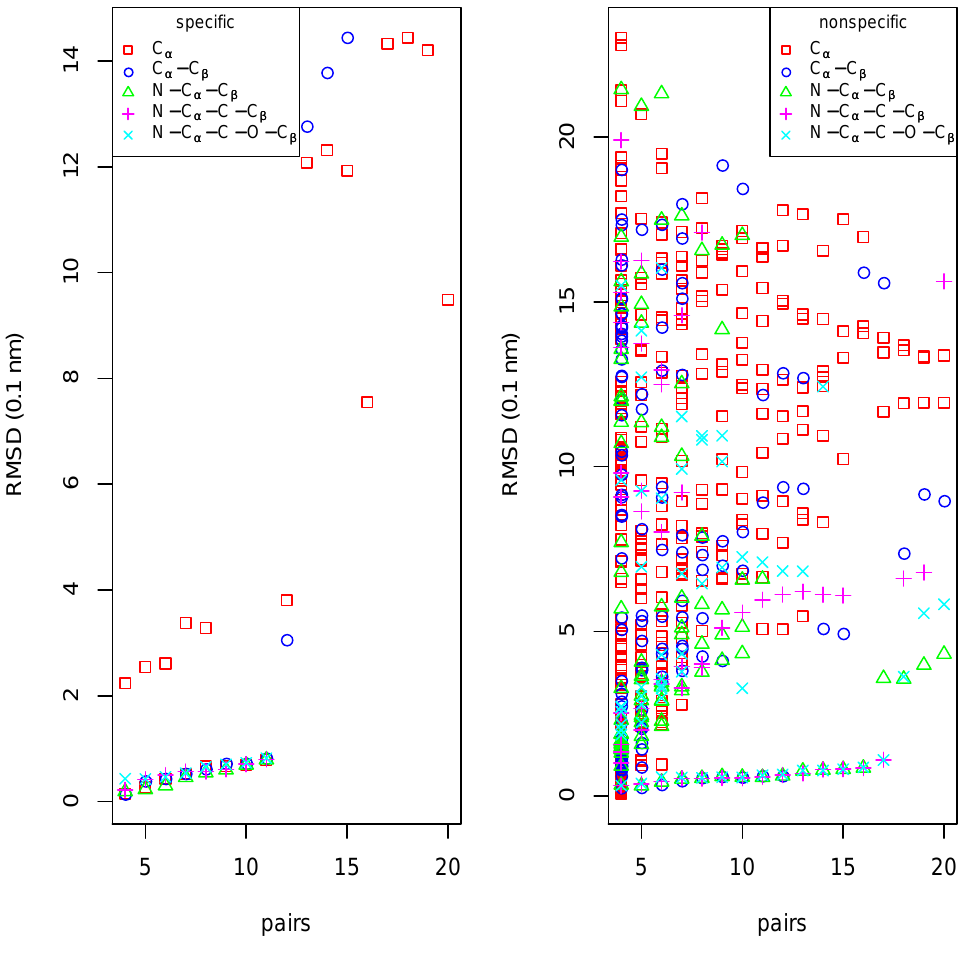
Figure 6. Results of amino-acid specific (left) and unspecific (right) searches for a match of the OAR binding epitope of yeast Hst2 on human Sir2 with various sets of atoms per